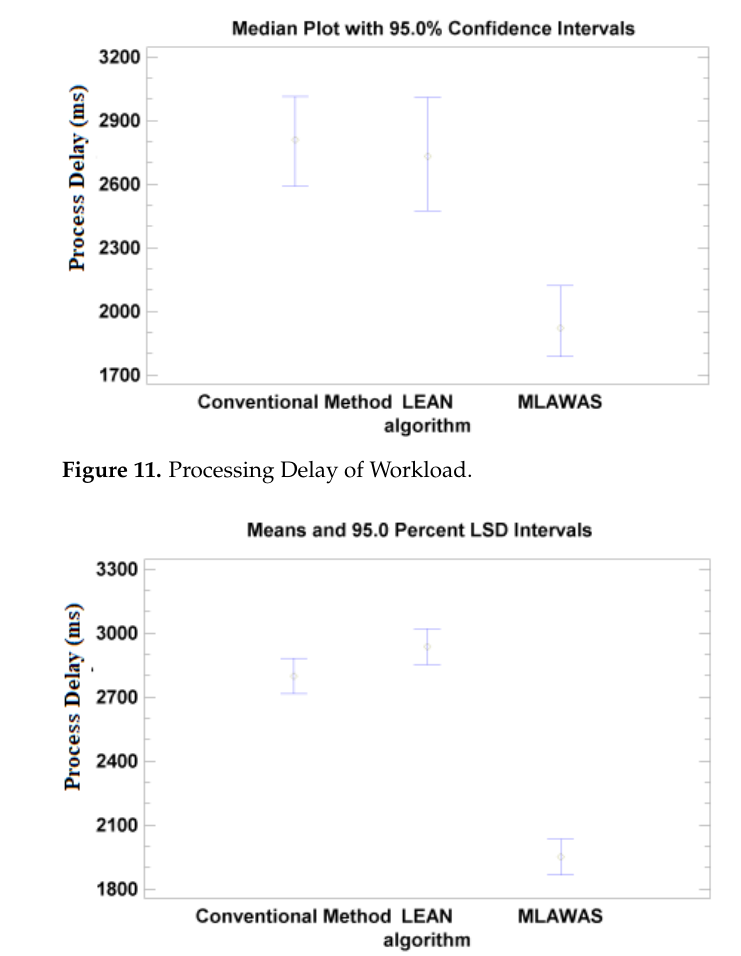
Figure 12. Processing Delay of